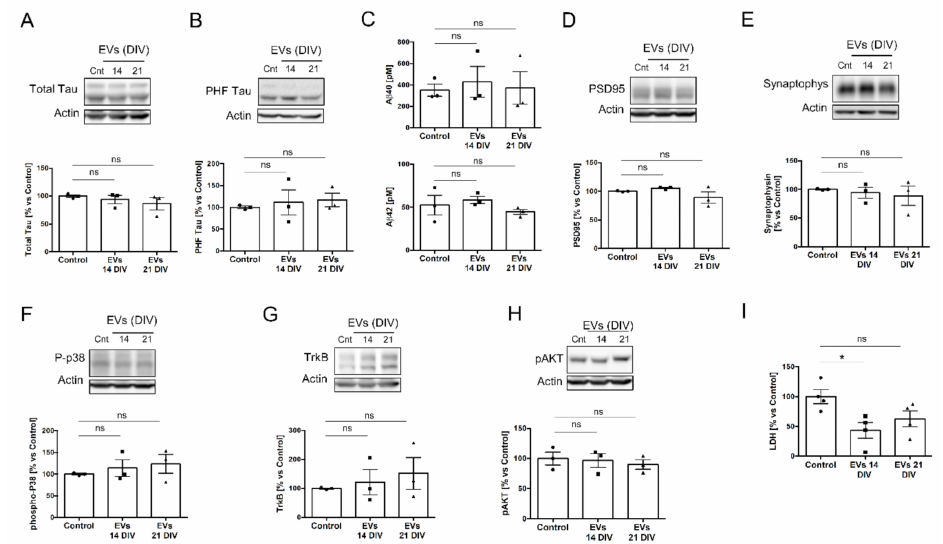
Figure 4. Biological effect of 14 and 21 DIV isolated EVs on 14 DIV rat cortical neural culture for a 48 h treatment period. ( A ) Western blot analysis of total tau protein in 14 DIV neural culture lysates untreated (cnt) or treated for 48 h with EVs isolated from the media of 14 DIV or 21 DIV neural cultures. Actin was used as loading control. The plot shows the levels for total tau protein normalized by actin and quantified from Western blot experiments as the ones shown in this panel. Graph shows the mean protein levels relative to the untreated (control) condition ± SEM ( B ) Same analysis as in panel A, but for tau phosphorylated at S396/T404 (PHF-1 epitope). ( C ) Plots comparing the A β 40 levels (upper graph) or the A β 42 levels (lower graph) in the media of rat cortical neural cultures untreated (control) or treated for 48 h with EVs isolated from the media of 14 DIV or 21 DIV neural cultures. Graph shows the A β concentration (pM) ± SEM. ( D ) Same analysis as in panel A was performed for the postsynaptic protein PSD95, ( E ) the presynaptic protein synaptophysin, ( F ) the phosphorylated form of p38, ( G ) the receptor for neurotrophins TrkB, and ( H ) the phosphorylated form of AKT at S473. ( I ) The plot compares the relative levels of lactate dehydrogenase (LDH) measured in the media of 14 DIV neural cultures untreated (control) or treated for 48 h with EVs isolated from the media of 14 DIV or 21 DIV neural cultures. All graphs show the mean LDH levels relative to the control condition ± SEM. Statistical significance was analyzed by one-way